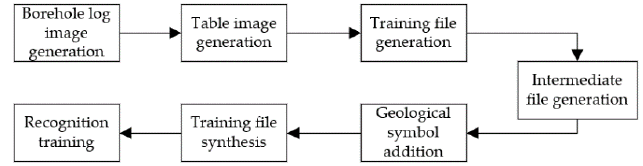
Figure 6. Training process of information extraction model.